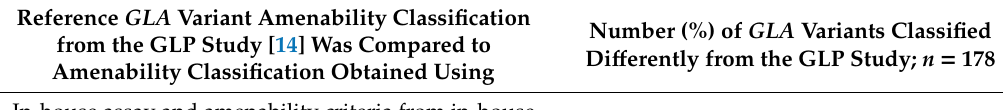
Table 2. Impact of the di ff erent amenability definitions on GLA variant